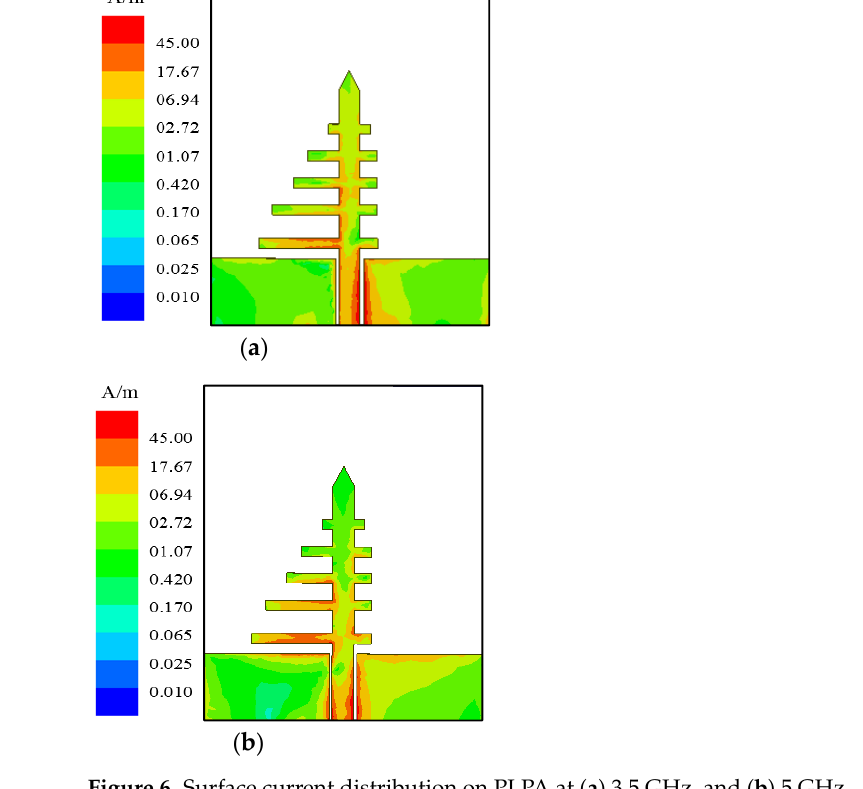
Figure 6. Surface current distribution on PLPA at ( a ) 3.5 GHz, and ( b ) 5 GHz.